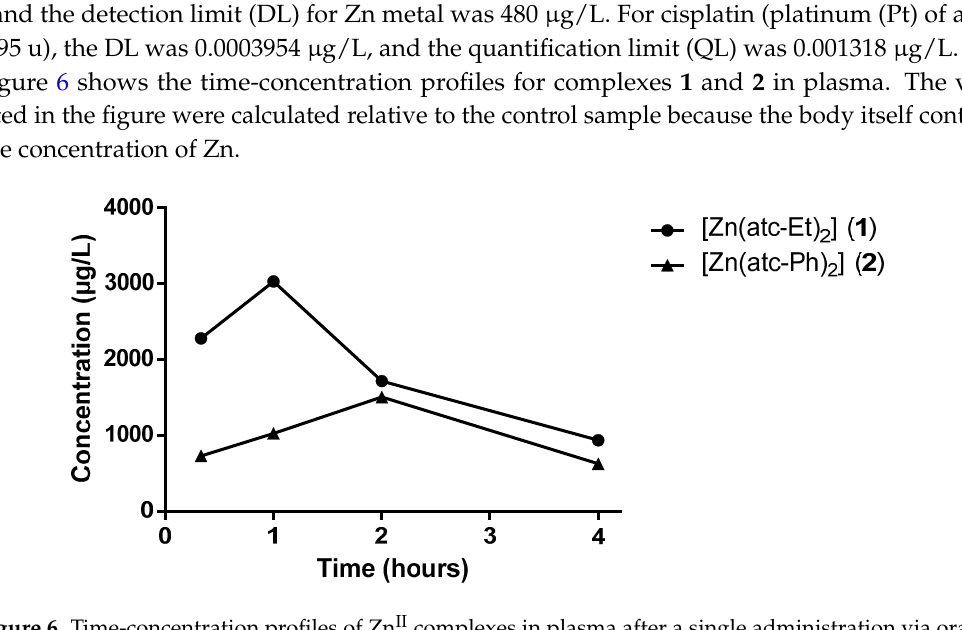
Figure 6. Time-concentration profiles of Zn II complexes in plasma after a single administration via oral gavage at a dose of 300 mg/Kg body weight.